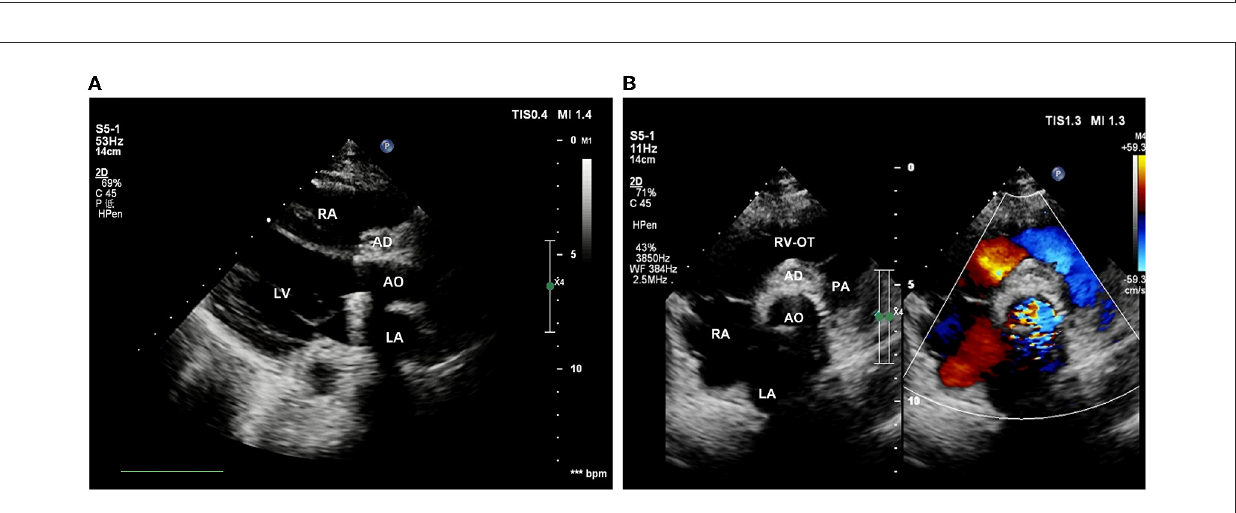
FIGURE4 Post-operative echocardiography. (A) The position and function of the artificial valved conduit are normal. (B) The aortic root bulge is successfully closed without an internal blood flow